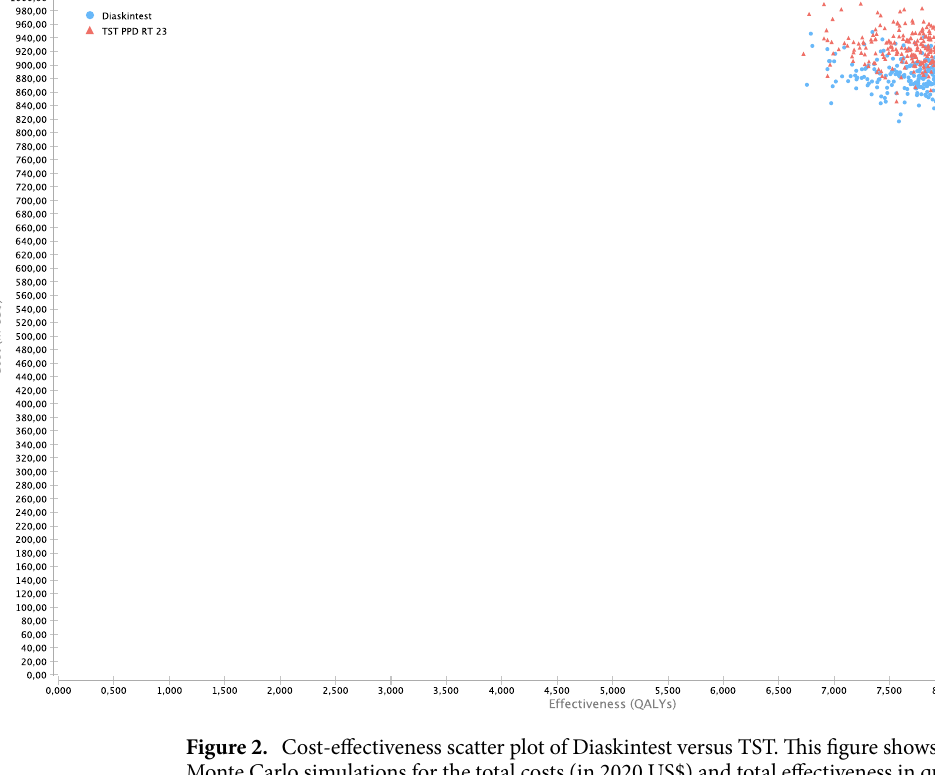
Figure 2. Cost-effectiveness scatter plot of Diaskintest versus TST. This figure shows a scatter plot of 10,000 Monte Carlo simulations for the total costs (in 2020 US$) and total effectiveness in quality-adjusted life years of the TST and Diaskintest strategies. TST tuberculin skin